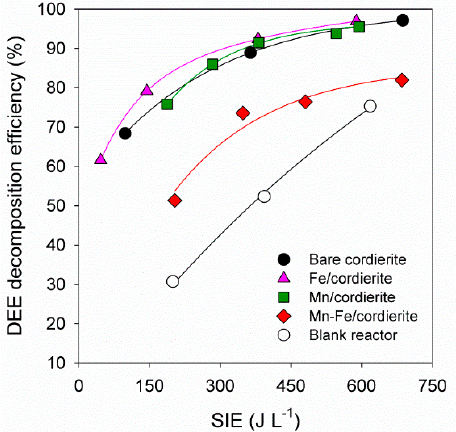
Figure 4. DEE decomposition efficiency in a one-stage reactor with different catalysts.